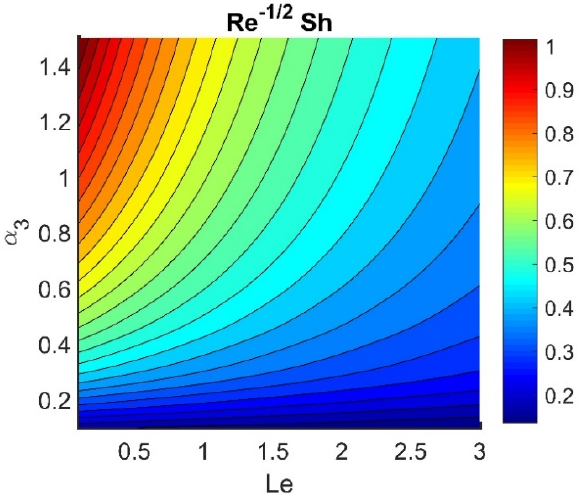
(cid:2879)(cid:2869) / (cid:2870) 𝑆ℎ .